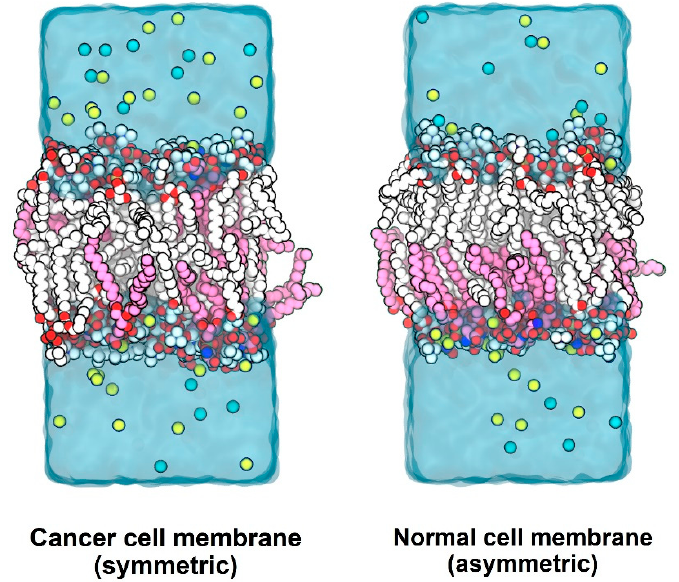
Figure 2. Equilibrated bilayer systems: Carbon atoms of POPC are shown in white, carbon atoms of POPS in magenta, sodium atoms in yellow and chloride atoms in cyan, with hydrogen atoms not shown. The outer (extracellular) leaflet is at the top and the inner (cytoplasmic) leaflet at the bottom. The normal cell membrane model contains POPS only in the inner leaflet, whereas the cancer cell membrane model contains POPS in both leaflets.